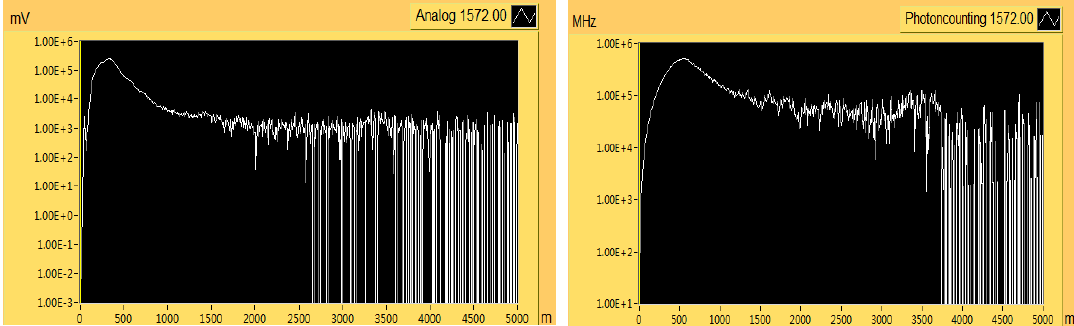
Figure 2. Lidar echo signal after distance correction ( left : AD signal, right : PC signal).